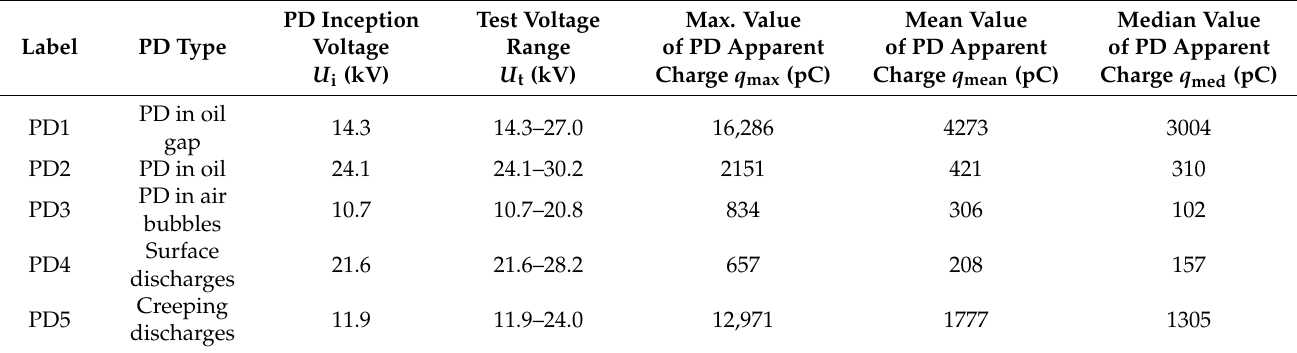
Figure 3. Schematic diagram of the measurement setup: U—high-voltage supply; Z—short-circuit current limiting resistor; TC—oil filled test chamber with electrode system for generating partial discharges; A—antenna; CK—coupling capacitor; CD—coupling device (measuring impedance); CC—connecting cable; M—conventional partial discharge measuring device; PC—computer; OSC— digital oscilloscope; LH—shielded high-voltage laboratory hall. Table 2. Parameters of the investigated types of partial